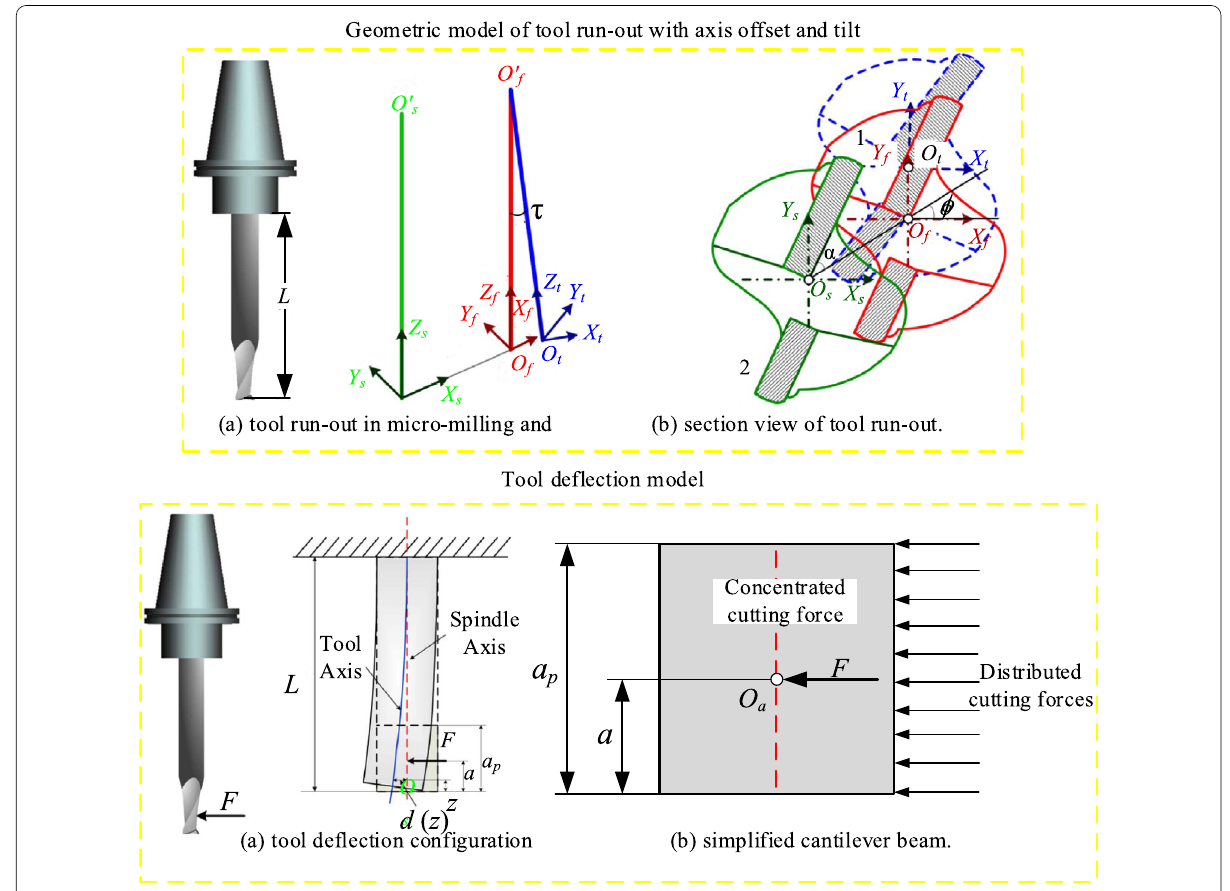
Fig.12. Tool deflection